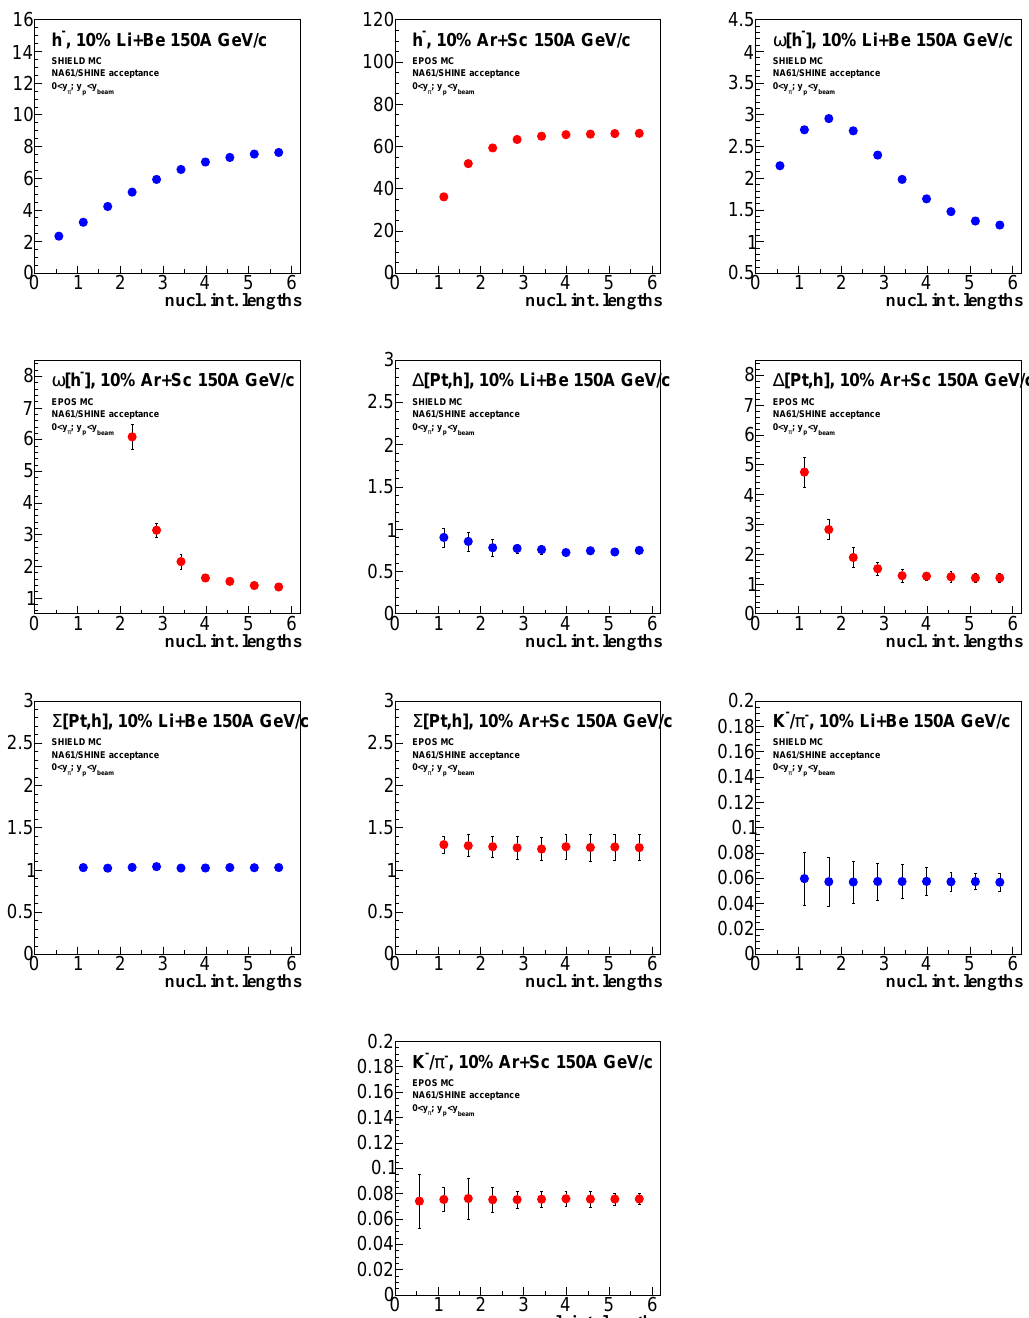
Figure 3. Comparison of different measures behavior versus the centrality calorimeter length for Li + Be (blue dots) and Ar + Sc (red dots) 150 A GeV/c collisions. The first two plots present an average number of negatively charged hadrons, the second two show the negative charged hadrons scaled variance, next four show two strongly-intensive quantities ∆ [Pt,h] and Σ [Pt,h] [14] and the last two show a ratio of the average number of negative charged kaons to the average number of negative charged pions. All results were calculated in the NA61/SHINE acceptance